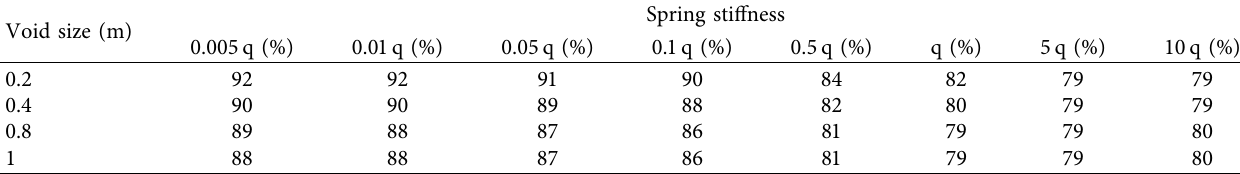
Table 8: Deflection load transfer coefficient under different values of spring stiffness and degree of void (semivoid state). Void size